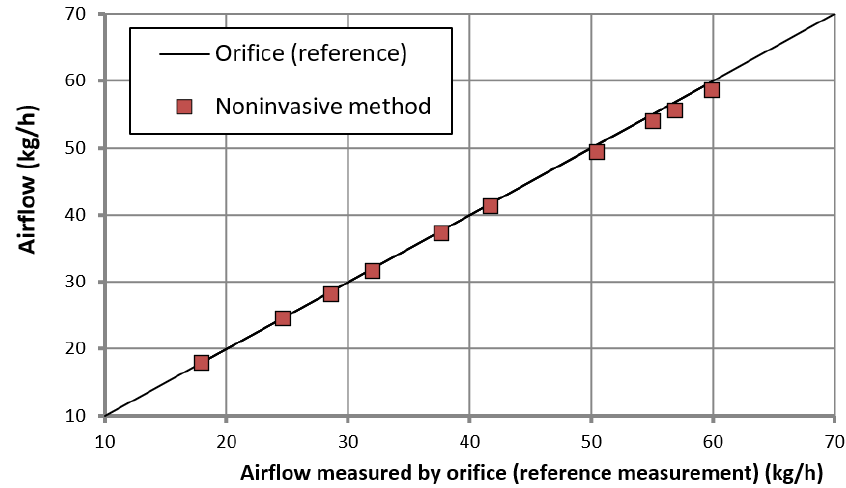
Figure A2. Comparison of the airflow measurement using noninvasive method and orifice plate flowmeter.